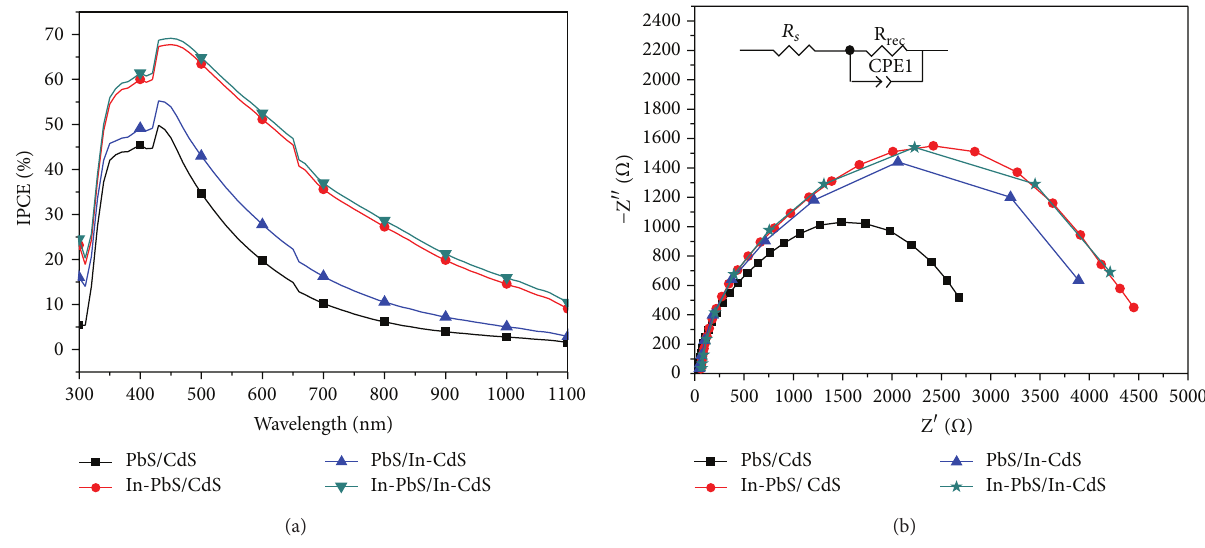
Figure 5: (a) IPCE spectra for four devices; (b) EIS spectra of QDSSCs measured in the dark at − 0.4 V bias voltages. The inset illustrates the equivalent circuit simulated. Rrecand CPE1represent thecharge transferresistanceand capacitance at TiO 2 /electrolyte interface, respectively; 𝑅 𝑠 is a series resistance.